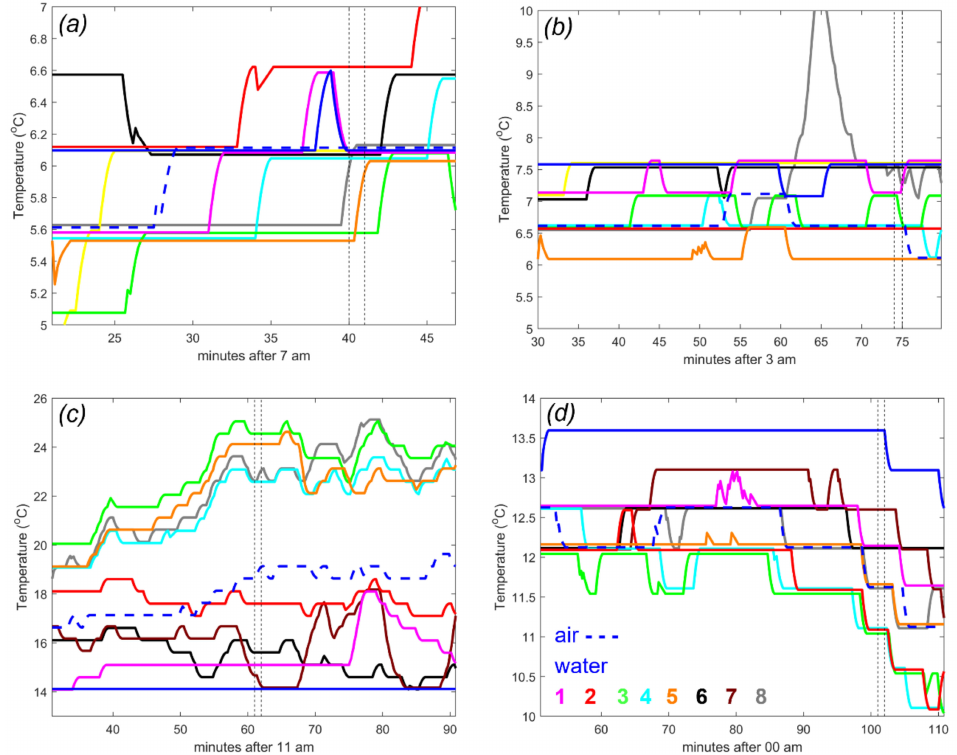
Figure A4. Temperature measurements using iButton dataloggers (1-min moving window over 0.1 Hz data) while the targets were deployed at sea for ( a ) survey 1, ( b ) survey 2, ( c ), survey 3, and ( d ) survey 4. Dashed lines indicate the FLIR recording minute and the numbers’ targets: 1-small PET, 2-large PET, 3-EPS white, 4-EPS blue, 5-HDPE, 6-binbag, 7-tarpaulin,